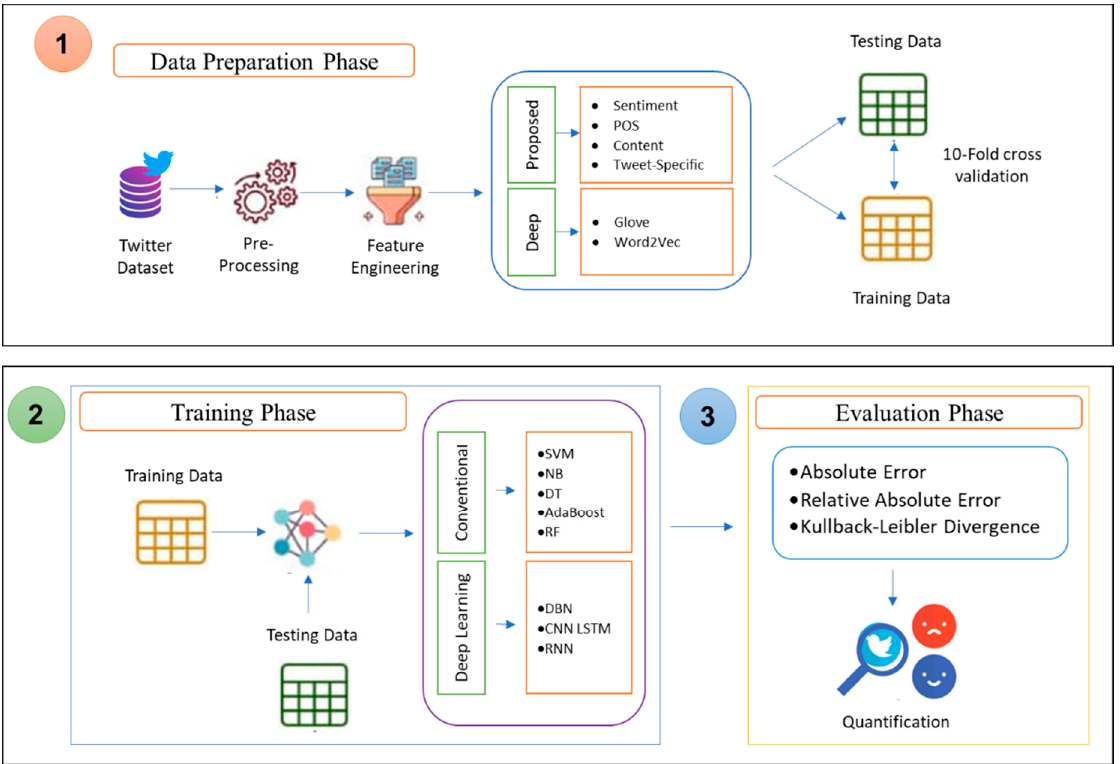
Figure 1. The proposed model for sentiment quantification.